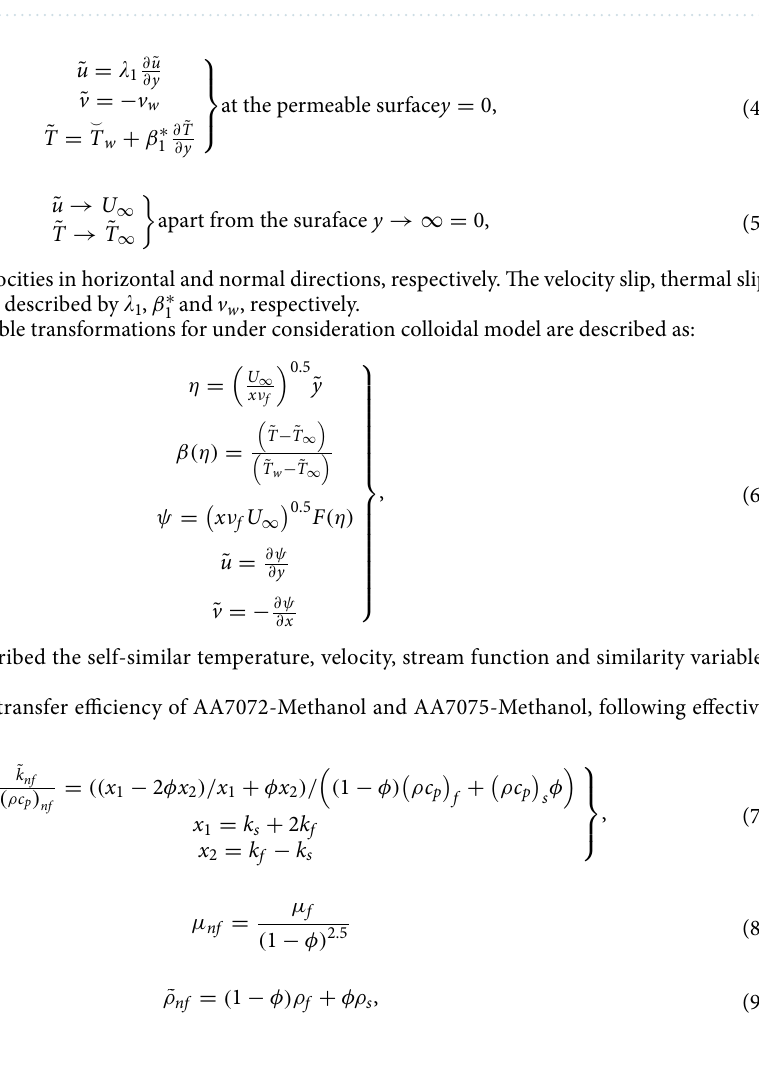
Figure 1. The flow of AA7072-Methanol and AA7075-Methanol over permeable